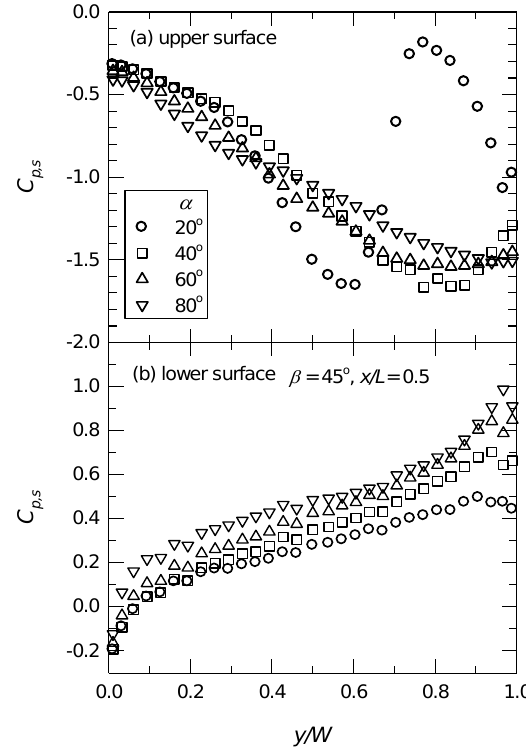
Figure 8. Mean spanwise pressure distributions for x/L = 0.5 and β = 45°.